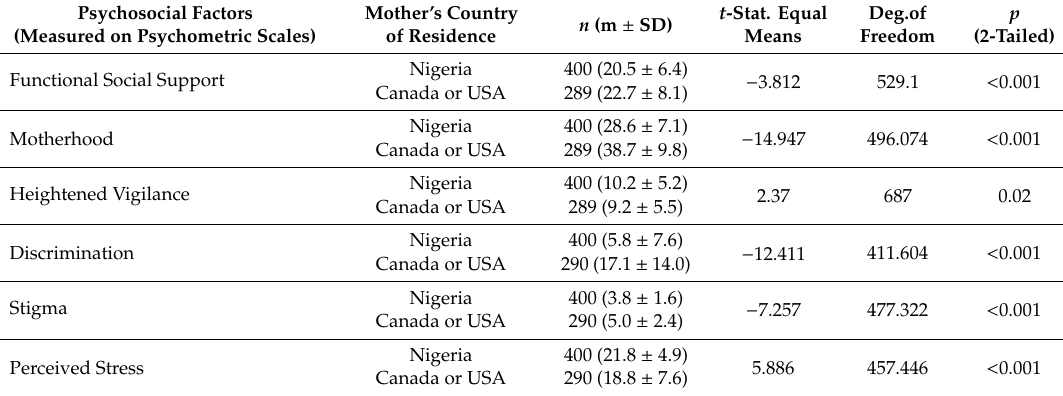
Table 4. Comparison of psychosocial experiences of mothers residing in Canada or U.S. with those living in